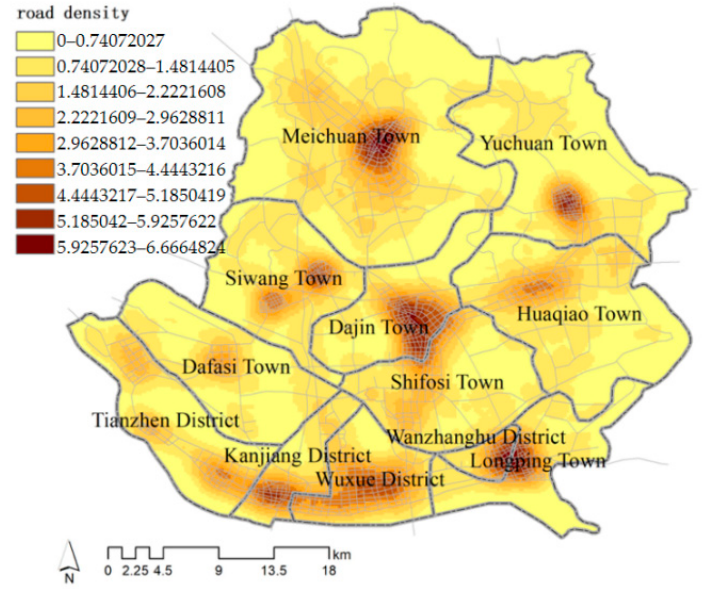
Figure 23. Analysis of road network density after modification.